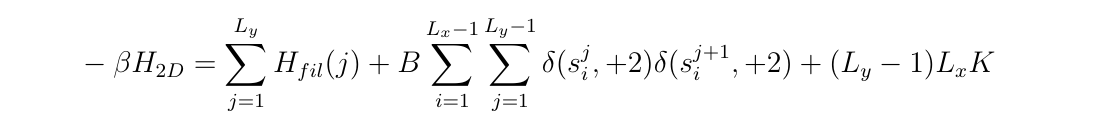
monomers per column in general. y